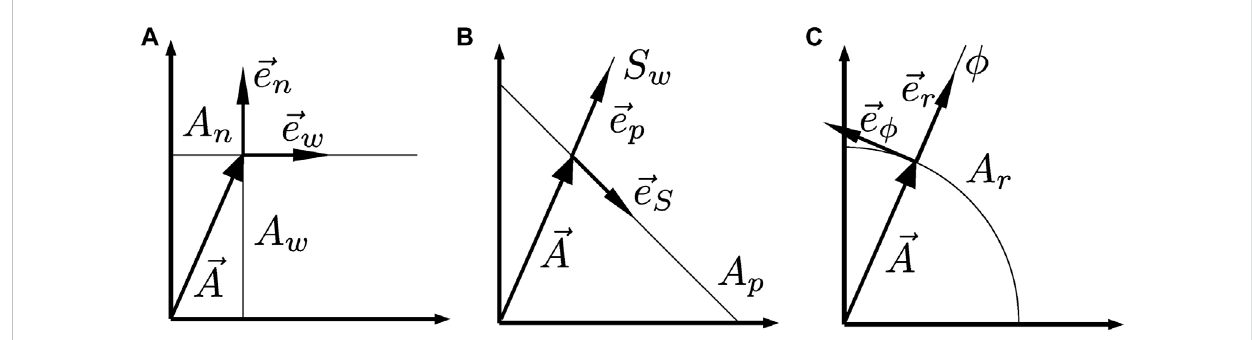
FIGURE 2 Three coordinate systems are illustrated and used to parametrize the transversal pore area. (A) The Cartesian coordinate system ( A w , A n ). A curve of constant A w and A n is indicated as A w and A n , respectively. Both A w and A n are extensive. The orthonormal basis set ( (cid:1) e w , (cid:1) e n ) is shown as attached to the point ( A w , A n ) . (B) Thesaturationcoordinatesystem ( A p , S w ) .Curvesofconstant A p and S w aredenotedby A p and S w inthe fi gure. A p isextensiveand S w is intensive.Thenon-orthonormalbasis ( (cid:1) e p , (cid:1) e s ) isshown. (C) Thepolarcoordinatesystem( A r , φ ).Curvesofconstant A r and φ aredenotedby A r and φ in the fi gure. A r is extensive and ϕ is intensive. The basis set ( (cid:1) e r , (cid:1) e ϕ ) is orthonormal. In all three fi gures, the transversal pore area as a vector (cid:1) A is